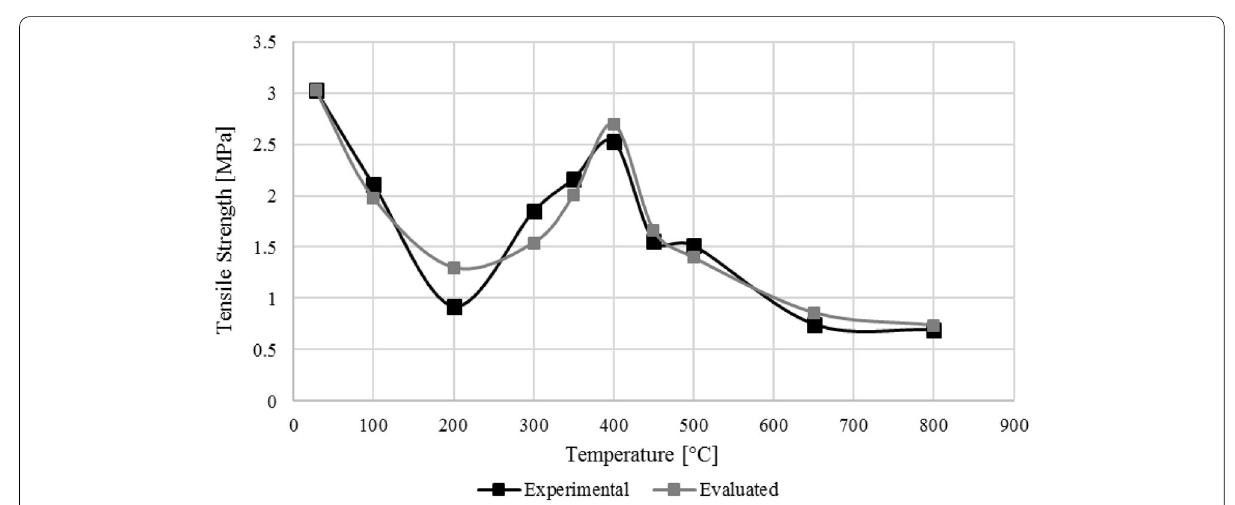
Fig. 10 Variation of the tensile strength at high